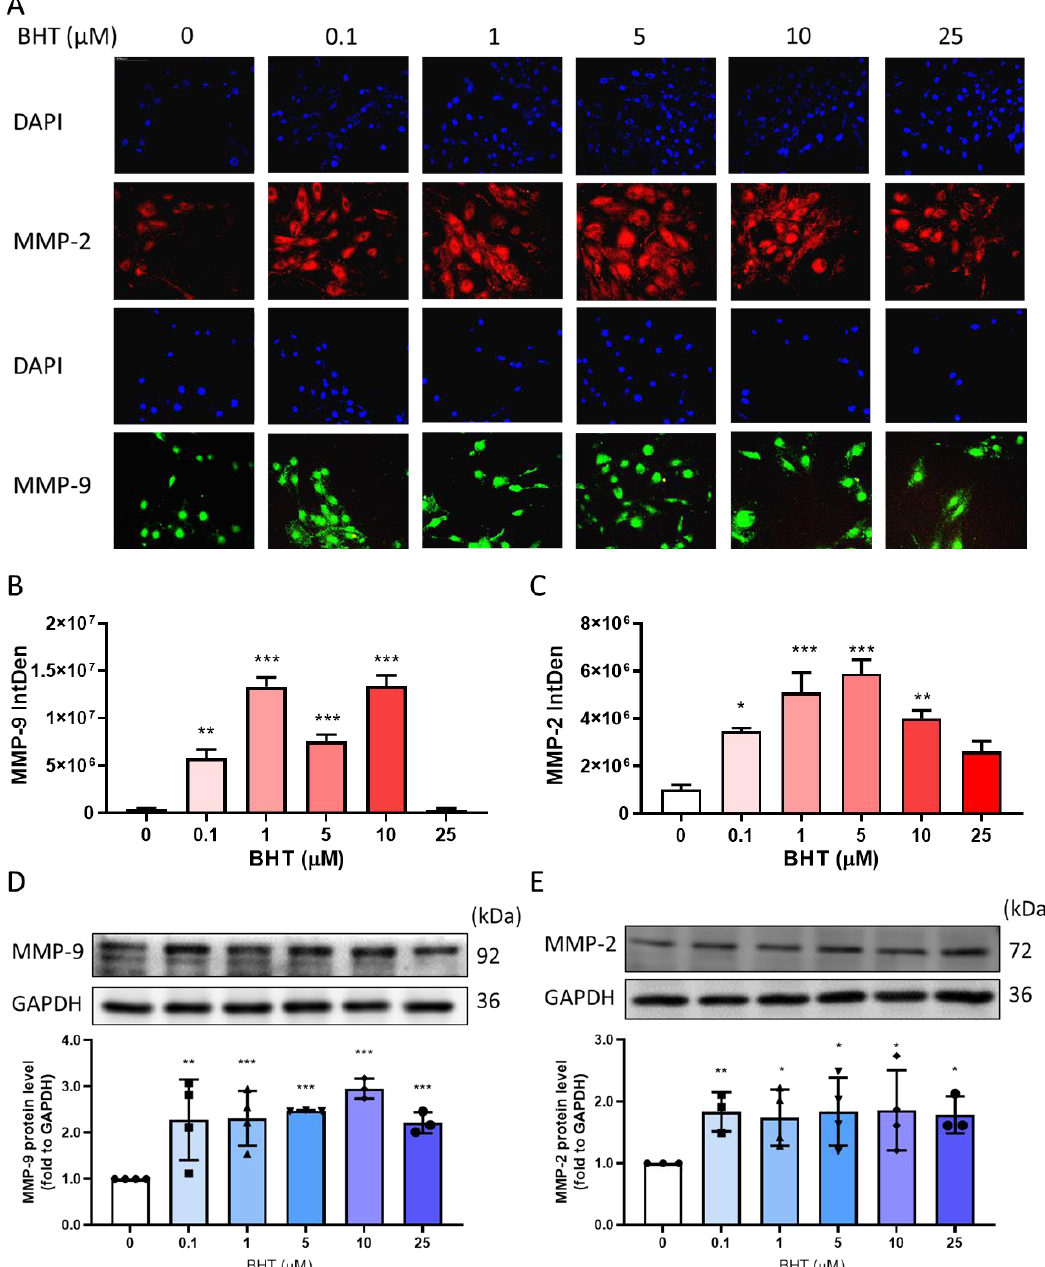
Figure 2. Effects of BHT on MMP modulation. ELT-3 cells were cultured in DMEM/F12 medium. After serum-free starvation for 24 h, cells were treated with different concentrations of BHT for 48 h, and the following experiments were performed: ( A ) immunofluorescence to measure expression changes, employing graphical representations of the fluorescence intensity levels of ( B ) MMP-9 and ( C ) MMP-2. Additionally, increased ( D ) MMP-9 and ( E ) MMP-2 protein expression ( n = 3–4) are shown. *, p < 0.05; **, p < 0.01; ***, p < 0.001, compared with the control group. We used a fluorescent microscope at 40 × magnification. IntDen: integrated density.